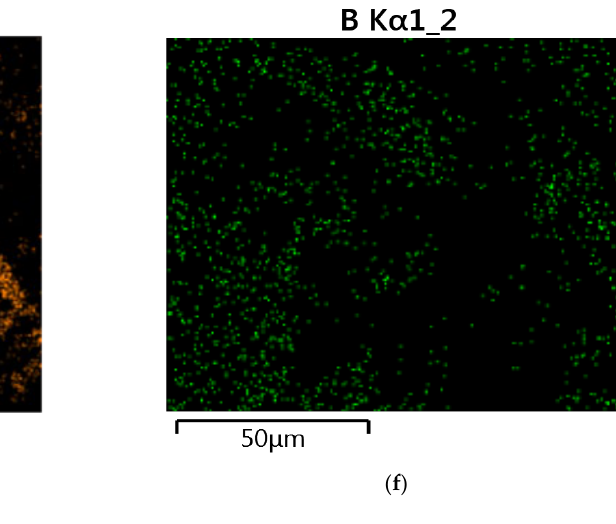
Figure 14. SEM image.